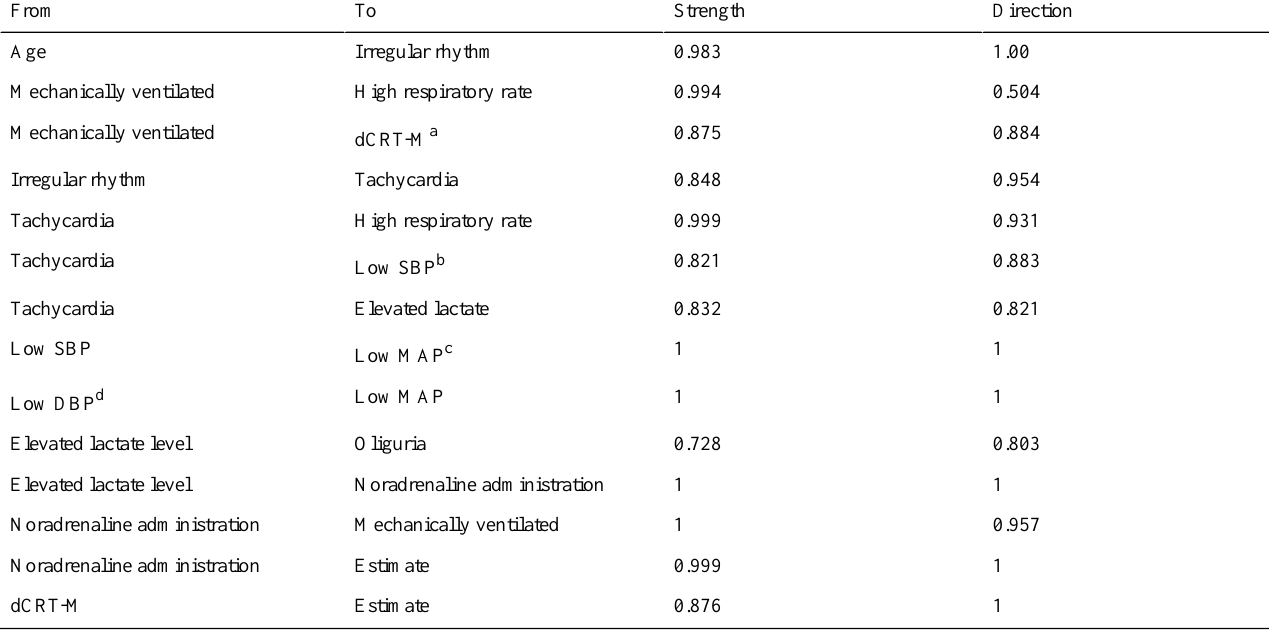
Table 2. Strength and direction coefficients of the consensus directed acyclic graph.